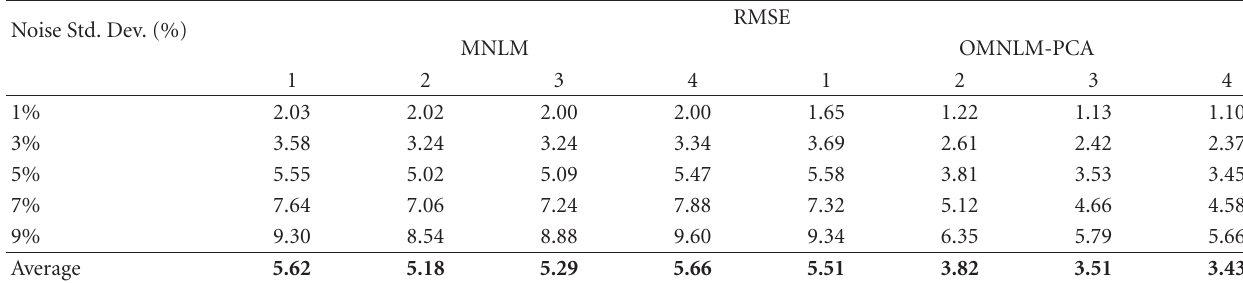
Table 2: Comparison of the MNLM method and the proposed method for di ff erent number of images. RMSE in the T1 image is presented for the filtering with each number of components and noise level. Noise Std. Dev. (%)